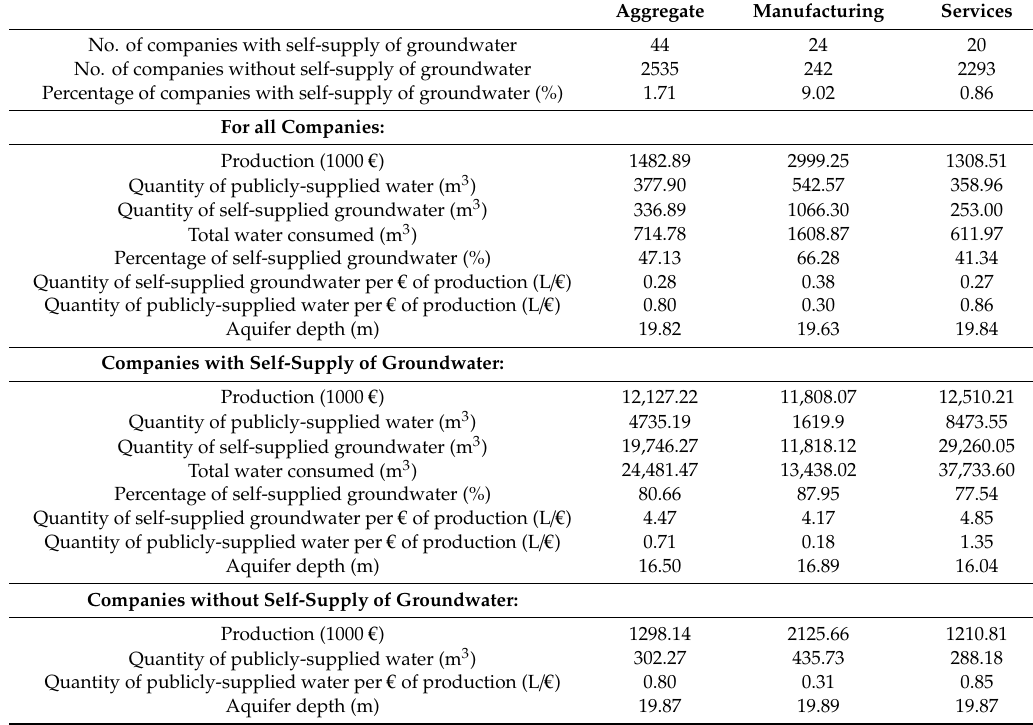
Table 1. Main magnitudes relating to water consumption. Average per company for 2012. Aggregate